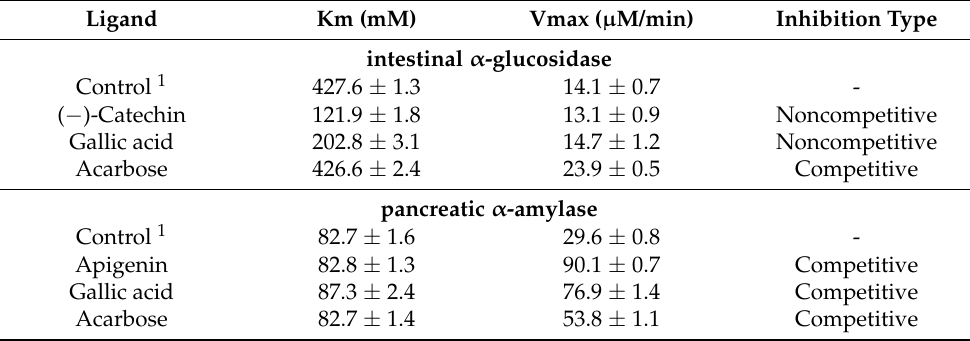
Table 1. Kinetic parameters of intestinal α -glucosidase and pancreatic α -amylase